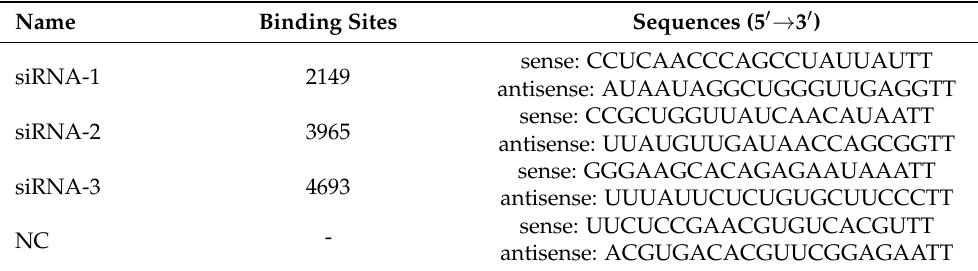
Table 3. Sequences of PAPPA2 siRNA and